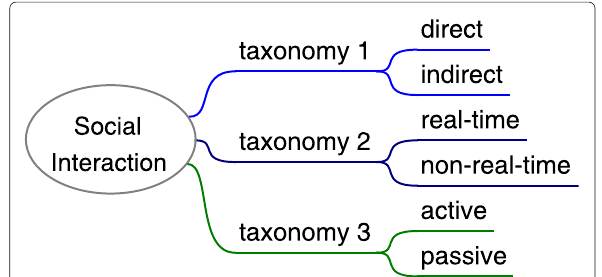
Fig. 12 Taxonomy of social interaction in social